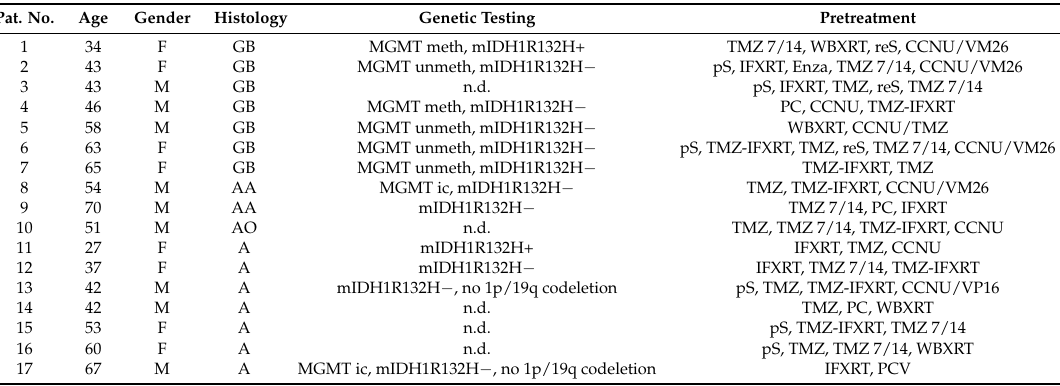
Table 3. Characteristics of patients with a diffuse growth pattern. Pat. No. Age